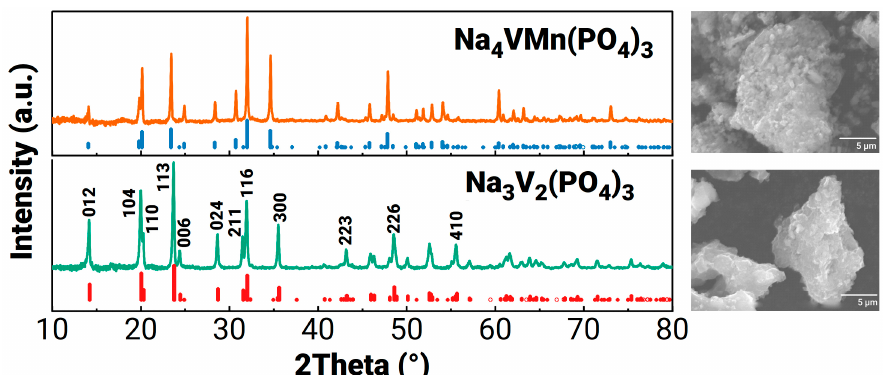
Figure 1. XRD patterns and SEM images of the as-synthesized Na 3 V 2 (PO 4 ) 3 (green) and Na 4 VMn(PO 4 ) 3 (yellow) cathode materials. Theoretical peak positions and intensities are shown by red and blue bars,